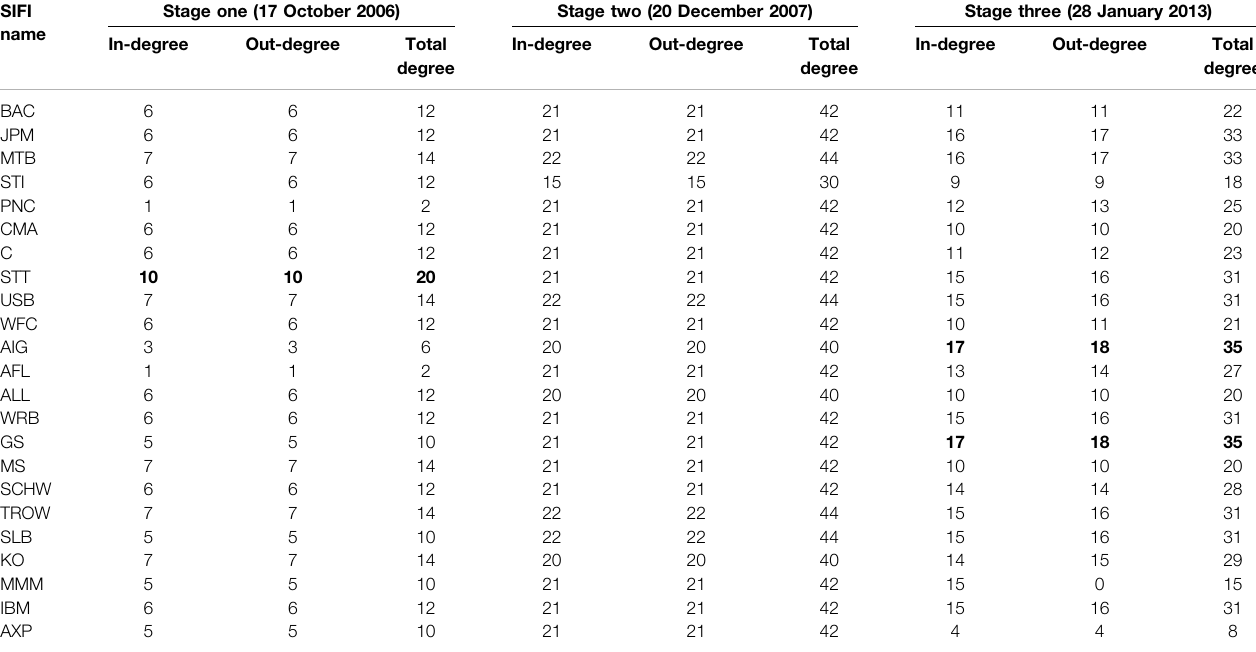
TABLE 4 | Degree of the US SIFIs.